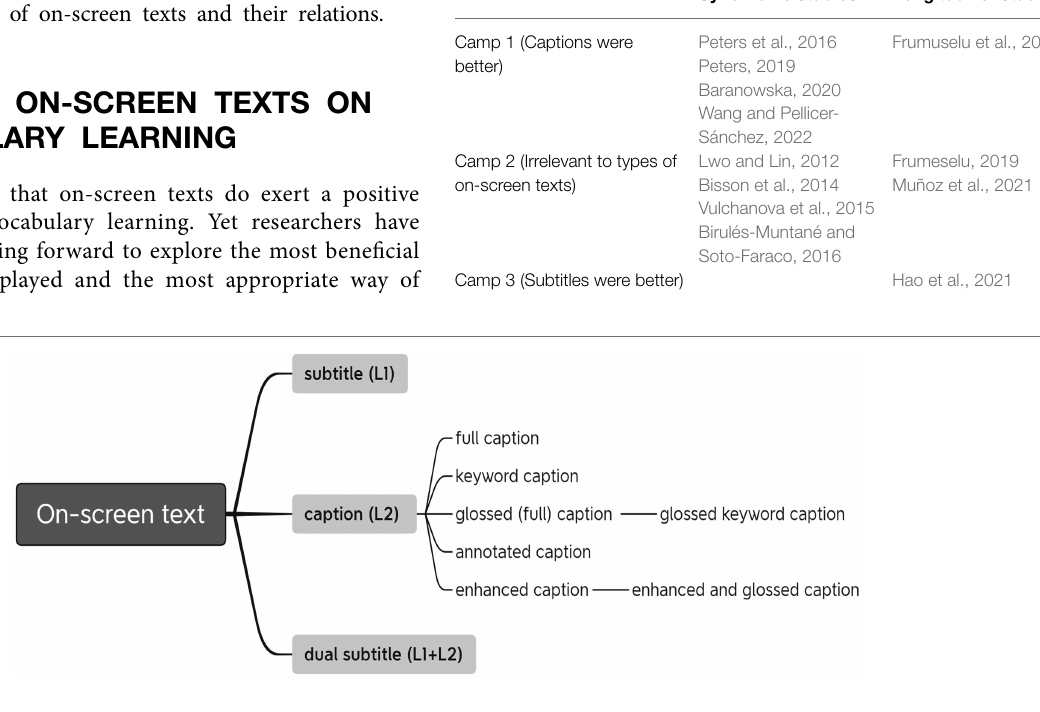
FIGURE 1 | Categories of on-screen texts and their relations.